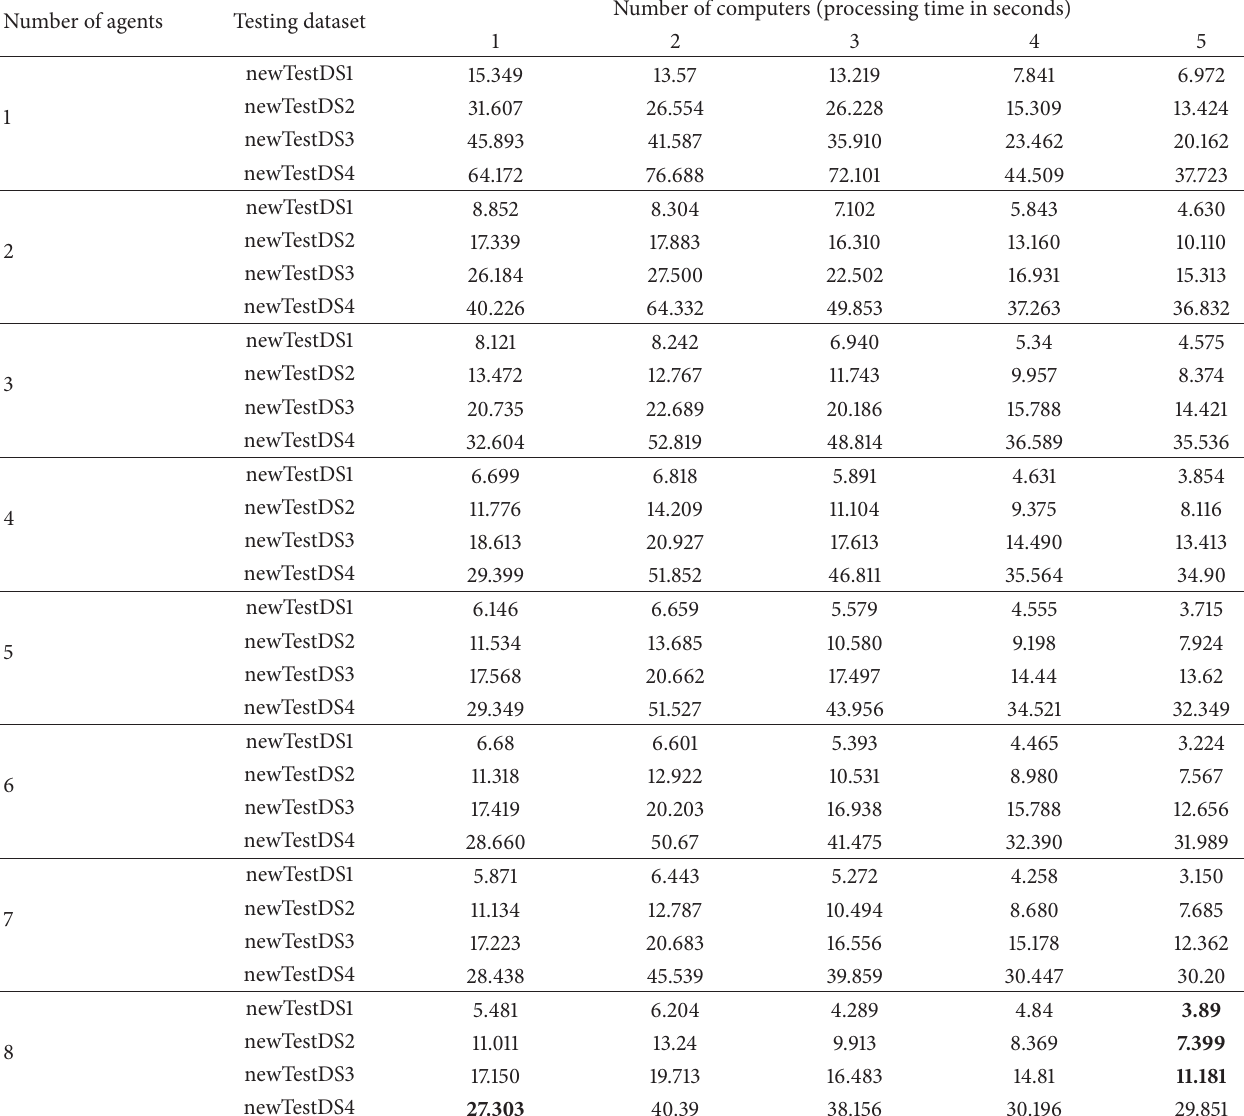
Table 5: Comparison of processing time required by MAS-IDS and other nonagents hybrid modified 𝐾 -means and C4.5. Number of